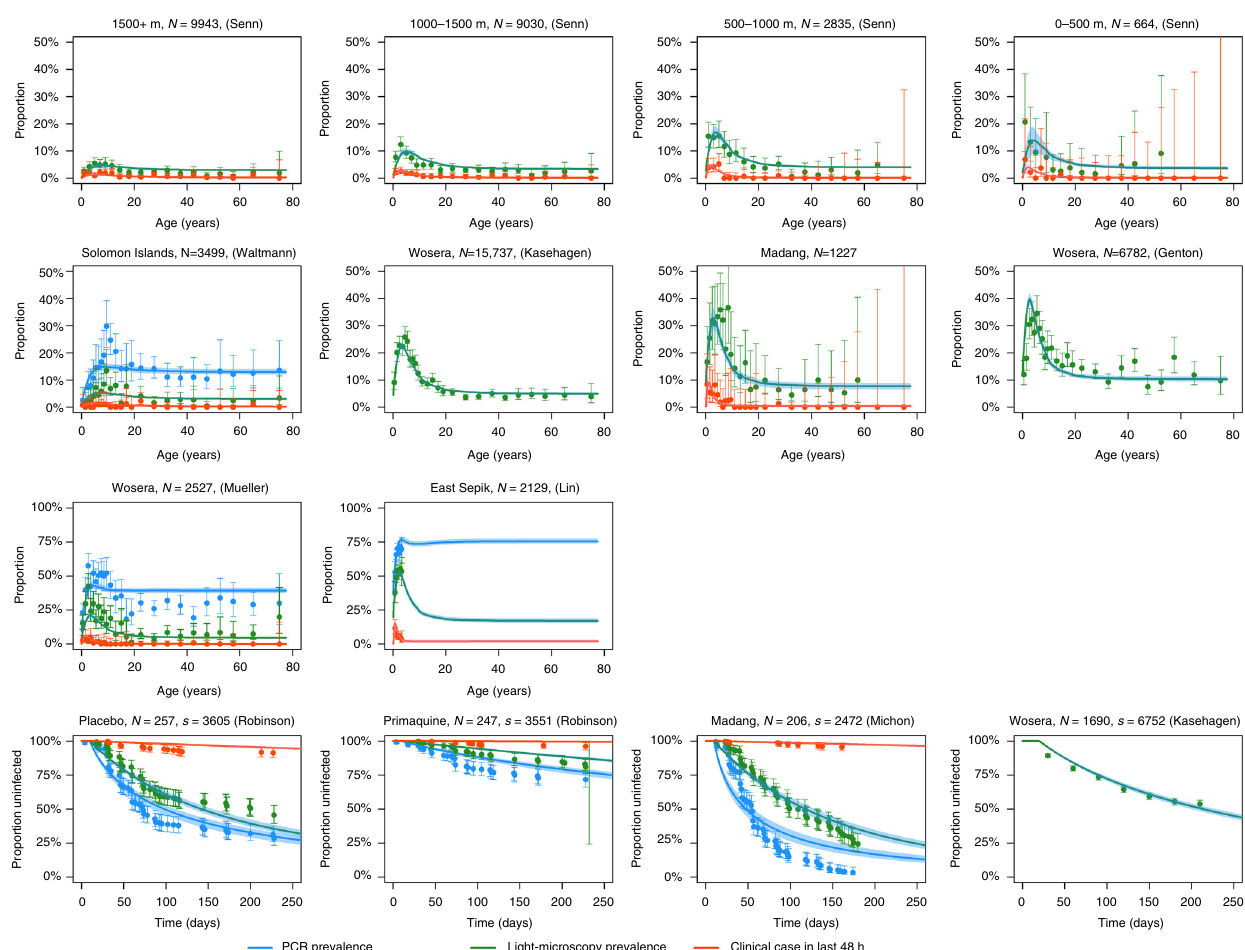
Fig. 1 Calibration of model to cross-sectional and longitudinal surveys from PNG and the Solomon Islands. For the cross-sectional surveys, the data are presented as age-strati fi ed estimates of prevalence with 95% con fi dence intervals. The same de fi nition of clinical malaria was used in all cross-sectional surveys: high density parasitaemia and fever ( ≥ 38 °C) in the last 48 h. The number of individuals in each cross-section is denoted N . For the longitudinal surveys in the bottom row, the data are presented as Kaplan – Meier estimates of proportion infected with 95% con fi dence intervals. The number of individuals included in longitudinal follow-up is denoted N and the total number of samples denoted s . The solid curves show the posterior median model prediction, and the shaded regions denote the 95% credible